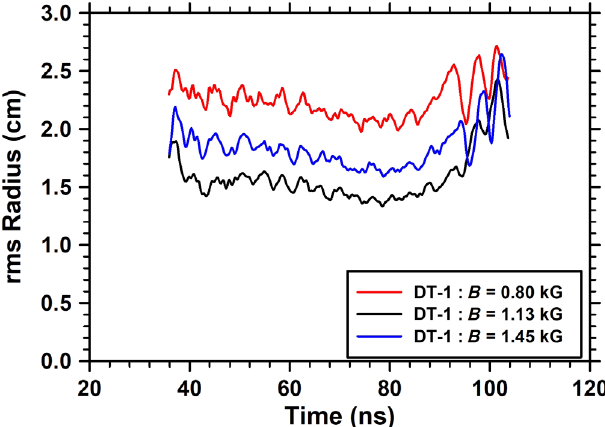
measurement.FIG. 13. Beam rms radius for the three settings of the DT-1 focusing solenoid; peak B ¼ 0 . 80 kG (red curve), peak B ¼ 1 . 13 kG (blue curve), and peak B ¼ 1 . 45 kG (black